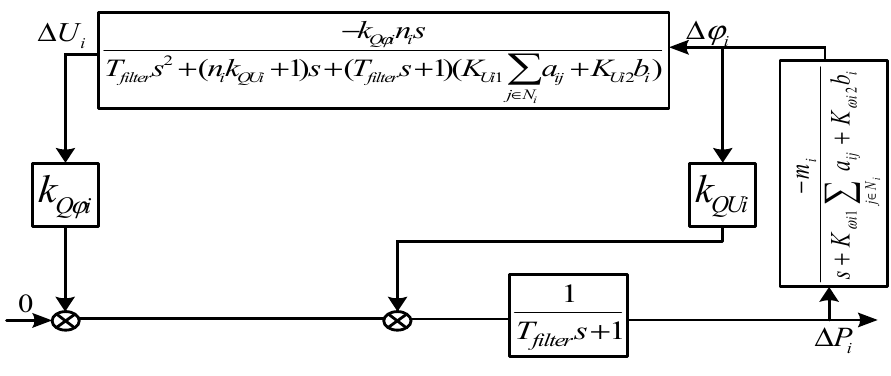
Figure 3. The small signal model of the i th DG.